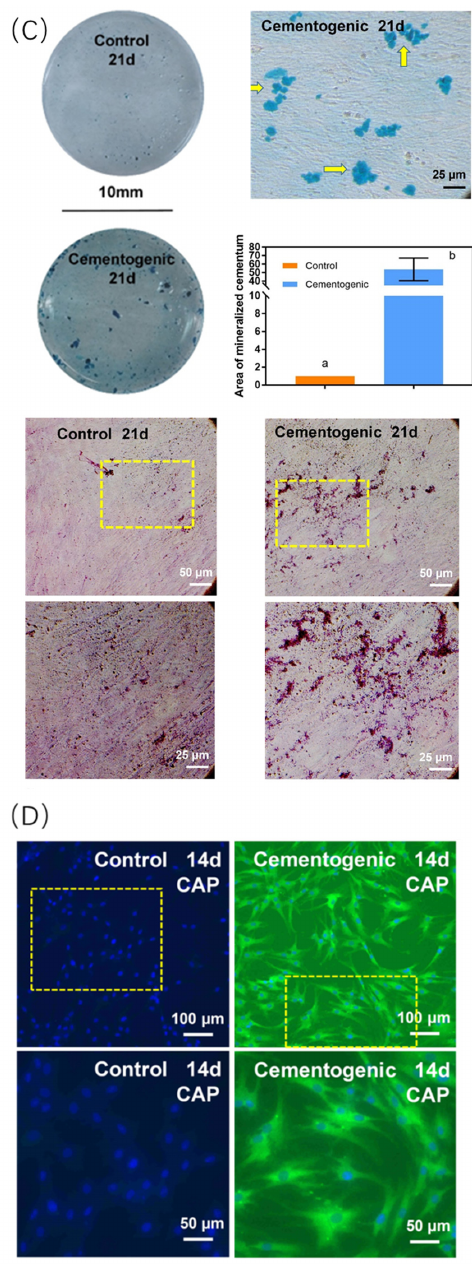
Figure 5. Triple differentiation potential of PDLSCs. ( A ) Osteogenic lineage. ( B ) Fibrogenic lineage. ( C , D ) Cementogenic lineage. Calf alkaline phosphatase (CAP) Values with dissimilar letters (a,b,c) are significantly different from each other ( p < 0.05). (Adapted from reference [39], with permission). In bone tissue engineering, when seeding on different scaffolds, such as CPC or polydopamine-templated hydroxyapatite (tHA), PDLSCs could interact with metformin and exert different effects. CPC scaffolds have nearly the same mechanical characters as cancellous bone and can upregulate PDLSC osteogenic expression [9,47]. The scaffold tHA could induce apoptosis by producing reactive oxygen species (ROS). However, when combined with metformin, tHA notably decreases ROS production, enhances the level of microtubule-associated protein 1 light-chain 3 II and BECLIN-1 and eliminates cell injury and apoptosis, resulting in increased seed cell osteogenic gene expression. Similarly, met- formin activates AMPK signaling pathways in the scaffolds despite their different upstream or downstream regulations. Moreover, PDLSCs could differentiate into fibrogenic